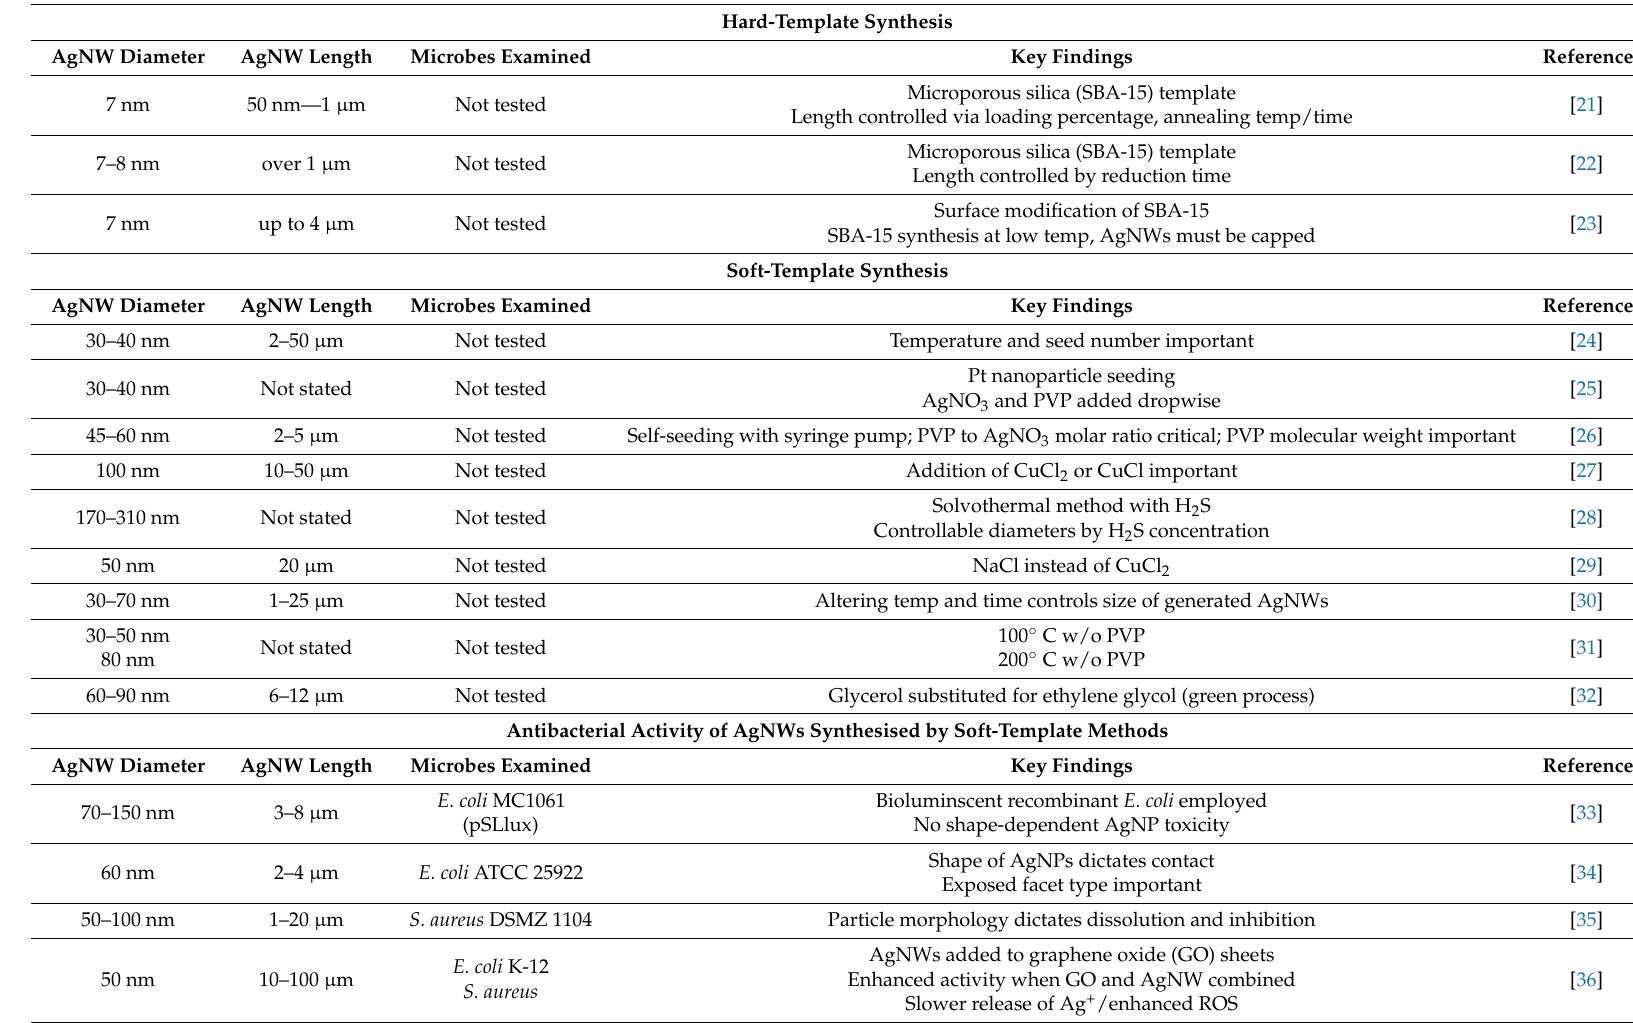
Table 1. Synopsis of synthesis methods, antibacterial activity and emerging applications found in this